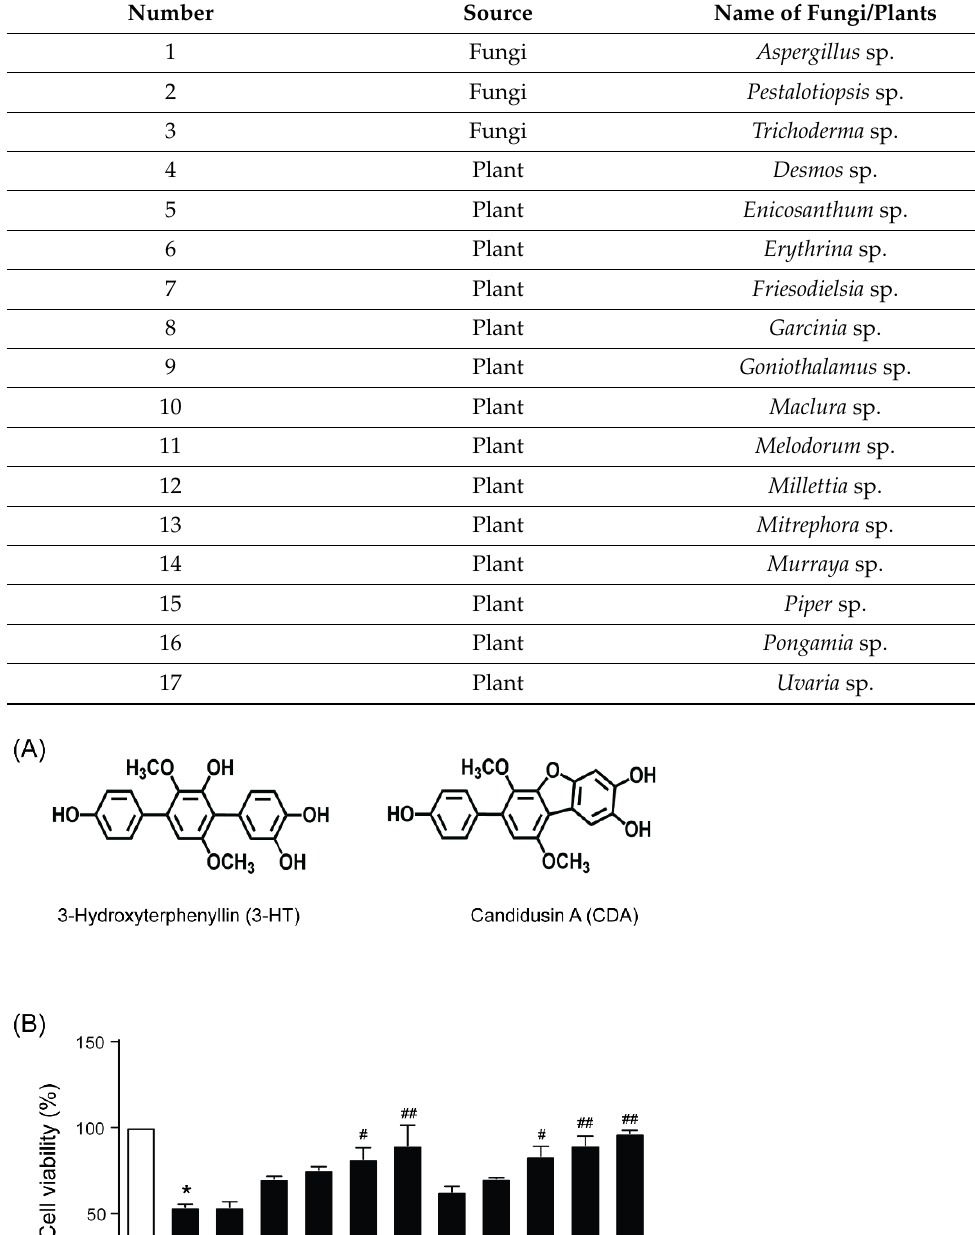
Table 1. List of fungi and plants from which the majority of the screened compounds were isolated.